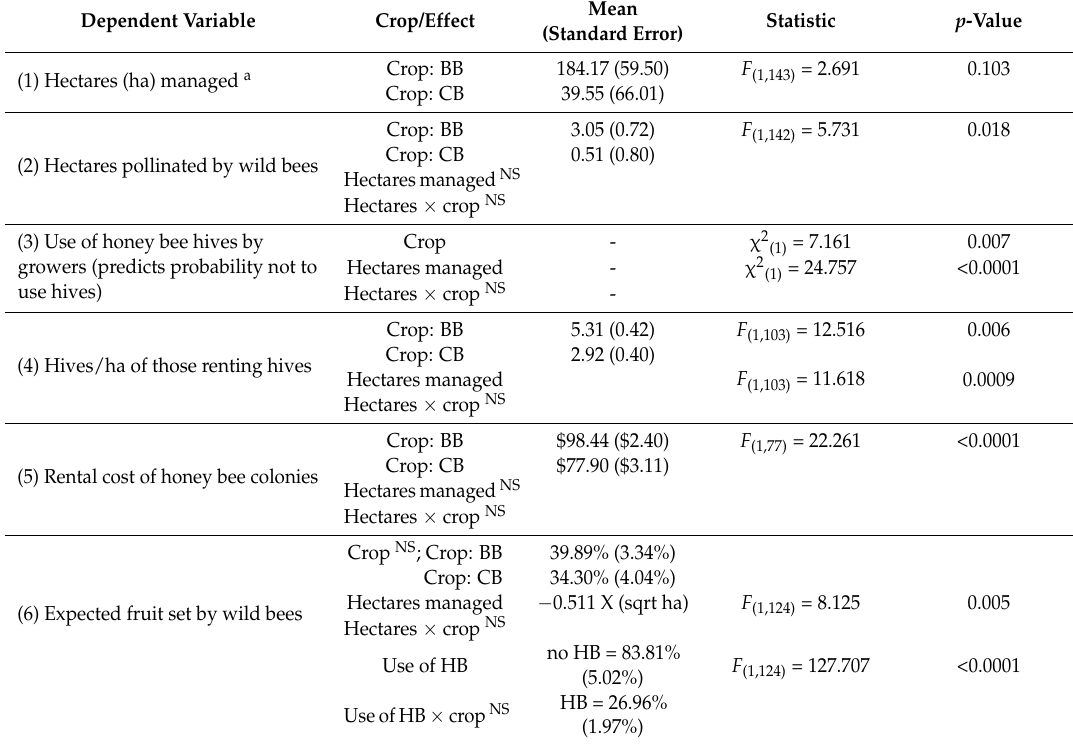
Table 2. Comparisons of use and characteristics of pollinators by wild blueberry (BB) producers in Maine, USA and cranberry (CB) growers in Massachusetts, USA using ANOVA and chi-squared tests. Mean Dependent Variable Crop/Effect Statistic p (Standard Error)